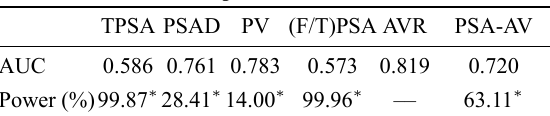
Table 4. Statistical power analysis of AVR and other